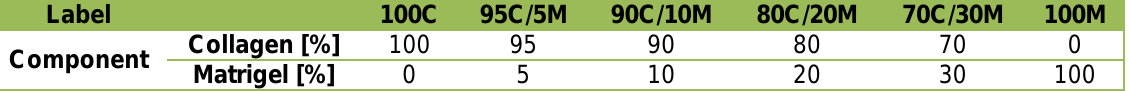
Table 1: Mixing ratios of collagen type I and Matrigel for monolayer cultivation Label 100C 95C/5M 90C/10M 80C/20M 70C/30M 100M Collagen [%] 100 95 Component Matrigel [%]